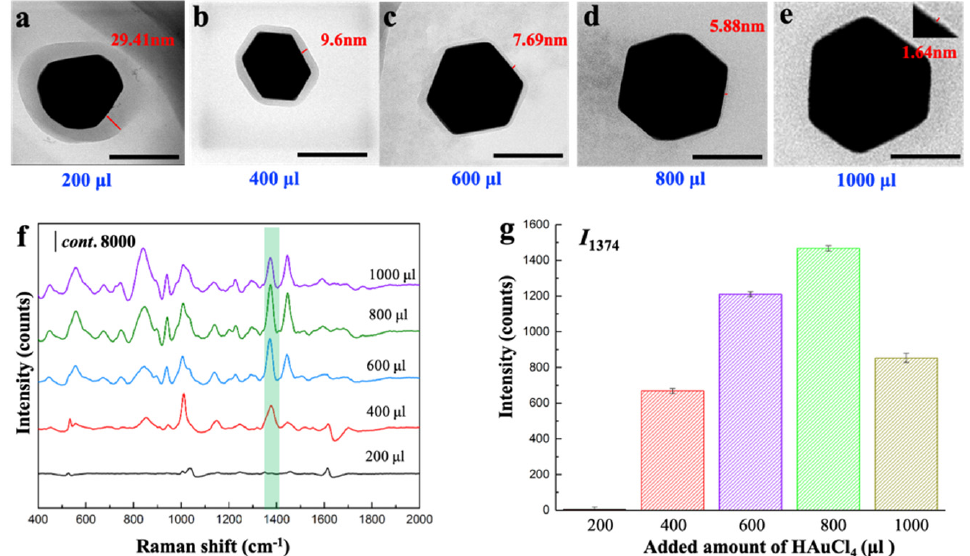
Figure 4. ( a – e ) Representative TEM images of core-shell Au@BUT-17 NP prepared with increased Figure 4. ( a − e ) Representative TEM images of core − shell Au@BUT − 17 NP prepared with increased amount of HAuCl 4 ( µ L). Scale bar: 100 nm; ( f ) SERS spectra of thiram; and ( g ) the comparison amount of HAuCl 4 ( μ L). Scale bar: 100 nm; ( f ) SERS spectra of thiram; and ( g ) the comparison of I 1374 1000 μ L.